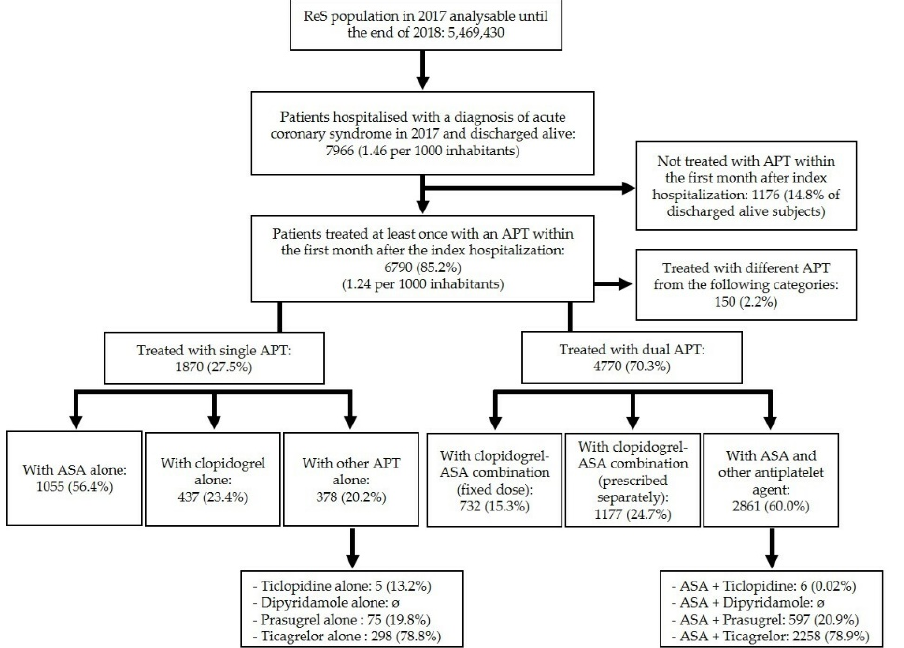
Figure 1. Patients discharged with acute coronary syndrome diagnosis in 2017 (index date) grouped by antiplatelet therapy (APT) or not at one month.